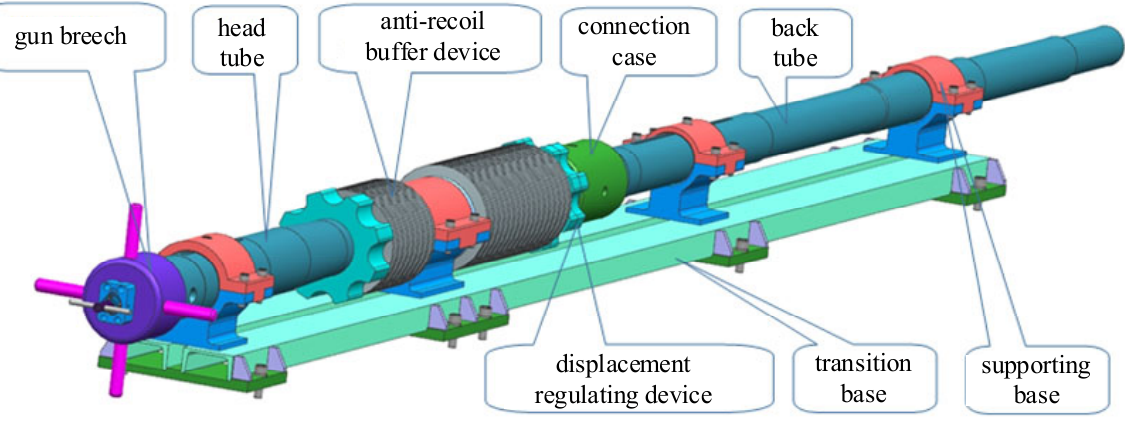
Figure 1. Sub-caliber fragment loading device with ultra-high speed [33].